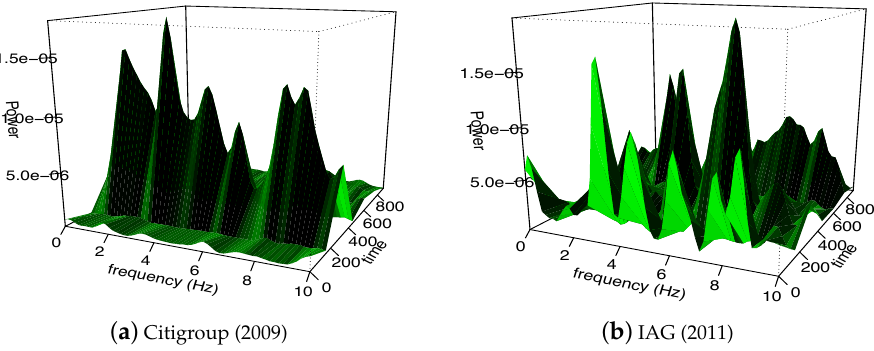
Figure 3. 3D power spectra of the financial data corresponding to Citigroup and IAG stock